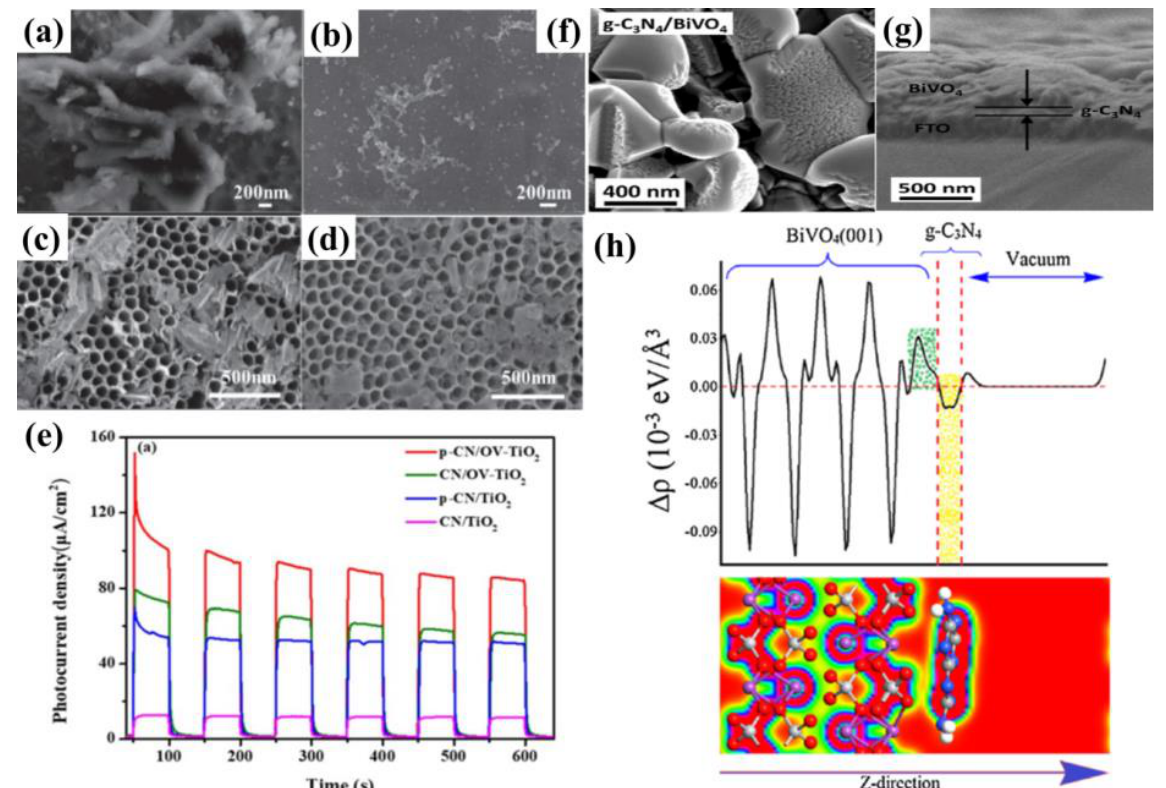
Figure 24. SEM images of ( a ) g−CN , ( b ) Proton-functionalized g−CN (p-CN), ( c ) g−CN /OV − TiO 2 and ( d ) p-CN/OV − TiO 2 . ( e ) Transient photocurrent response in 0.1 M Na 2 SO 4 at 0.6 V vs. SCE. Reprinted with permission from ref. [241] Copyright 2020 Electrochemical society. FESEM images of the top-view ( f ) and cross-section ( g ) of the BiVO 4 electrodeposited on g−CN and ( h ) e rence (Δρ) along Z-direction for g−CN /BiVO 4 . Reprinted with permission from ref. [35] Copyright 2018 Elsevier.